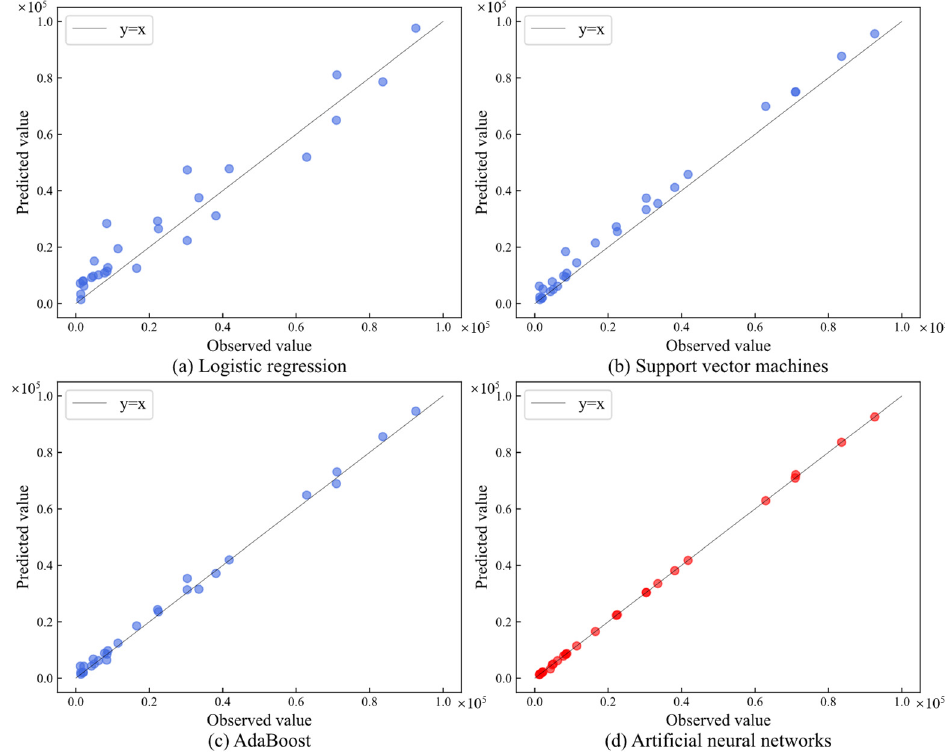
Figure 11. Comparison chart of prediction results of the ANN and the classical regression prediction model: ( a ) LR; ( b ) SVM; ( c ) AdaBoost; ( d ) ANN.